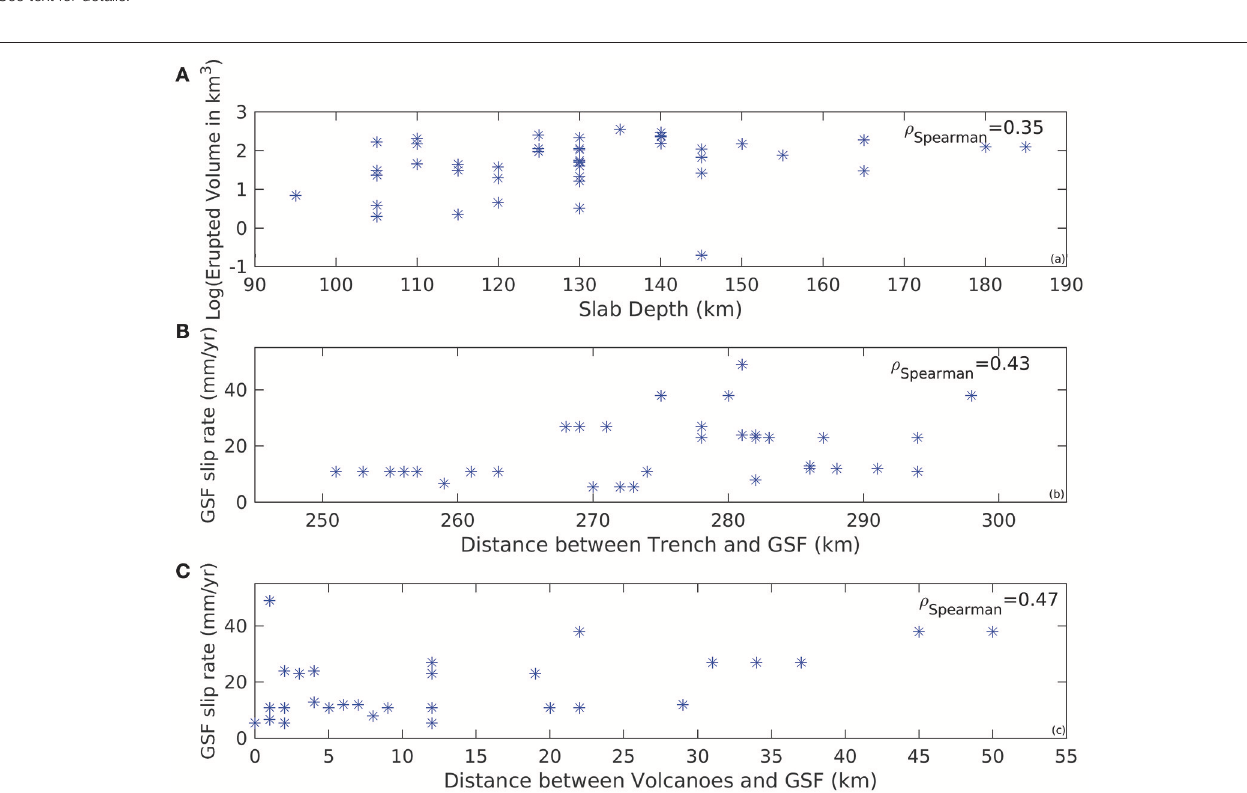
FIGURE 7 | (A) Log of the erupted volumes along the Sumatra arc as a function of the slab depth; (B) Slip rate of the GSF as a function of the distance between the trench and the GSF. (C) Slip rate of the GSF as a function of the distance between the volcanoes and the GSF. See text for